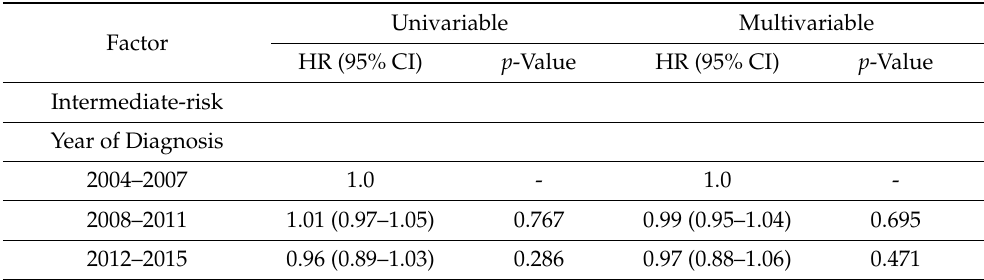
Table 7. Unadjusted and adjusted hazard ratios (HR) for respective univariate and multivariate Cox proportional hazard models of overall survival in intermediate-risk prostate cancer patients who received one of the six